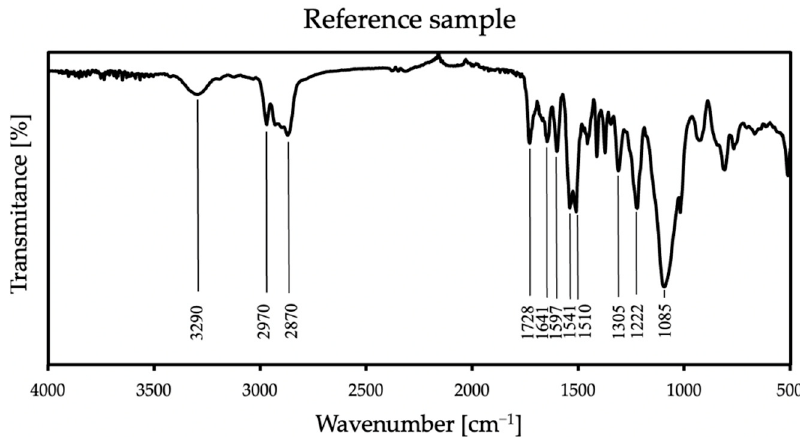
Figure 4. FT-IR spectra of the reference sample.